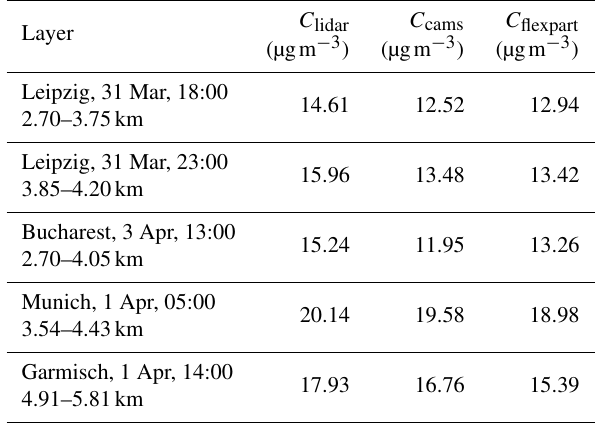
Table 2. Comparison of sulfate concentration computed from lidar measurements, CAMS products, and FLEXPART for layers at lidar stations associated with layers from Pillersdorf, 2 April 2014,